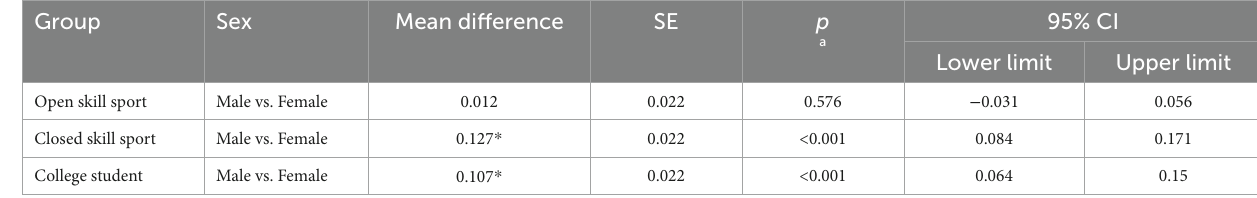
TABLE 2 Sex and group